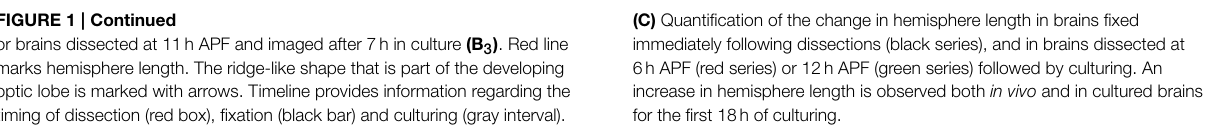
(C) Quantification of the change in hemisphere length in brains fixed immediately following dissections (black series), and in brains dissected at 6h APF (red series) or 12h APF (green series) followed by culturing. An increase in hemisphere length is observed both in vivo and in cultured